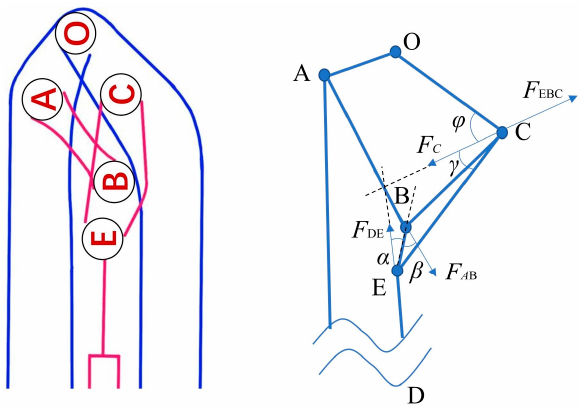
Figure 3. Schematic of cylinder #i (i = 2, 3, 5) and its linkage mechanism.